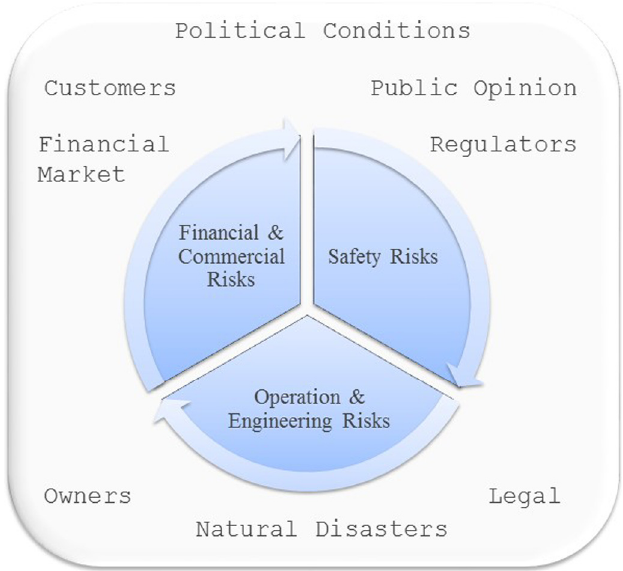
Fig. 1. Risk management environment model for a nuclear power plant operator. The aim of the GE-ORNL team is to minimize engineering risks by using FeCrAl